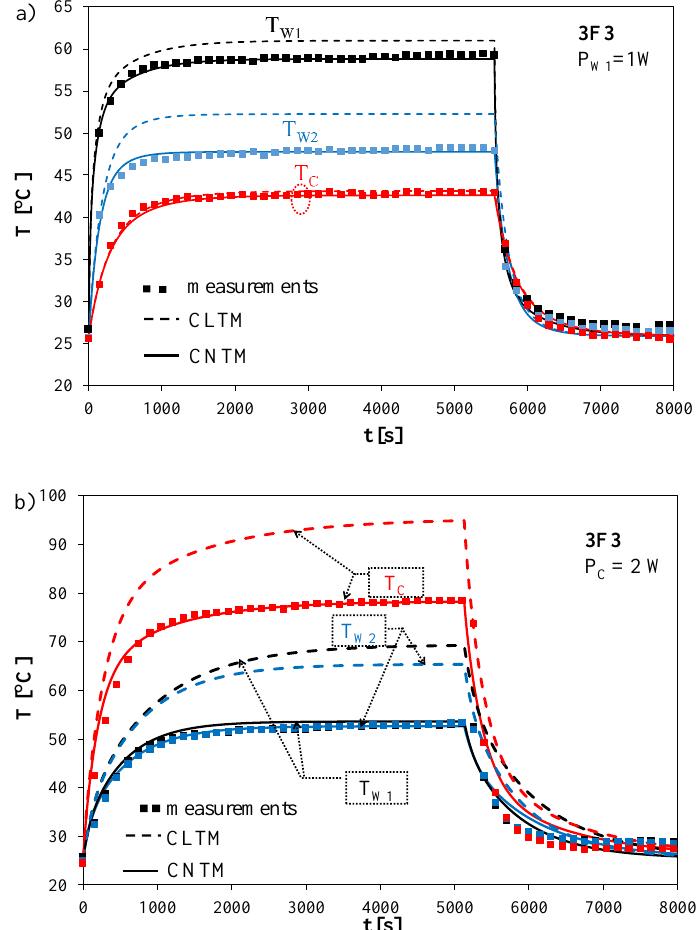
Figure 10. Measured and calculated waveforms of the temperature of the primary winding T W1 , the temperature of the secondary winding T W2 and the temperature of the core T C of the planar transformer at P W1 of 1 W in the primary winding ( a ) and P C of 2 W in the core ( b ).